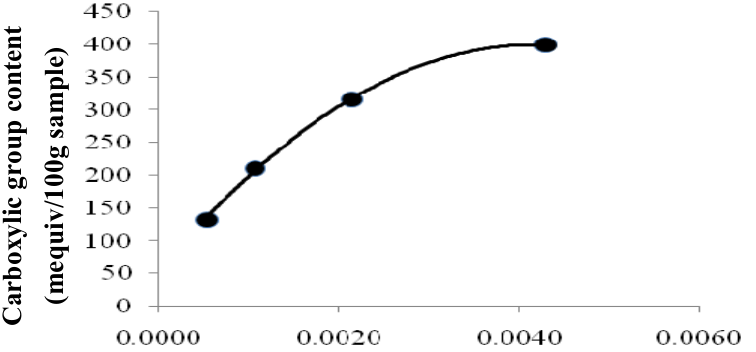
Figure 9. Effect of maleic acid concentration on the carboxyl group content of esterified Tamrix articulata